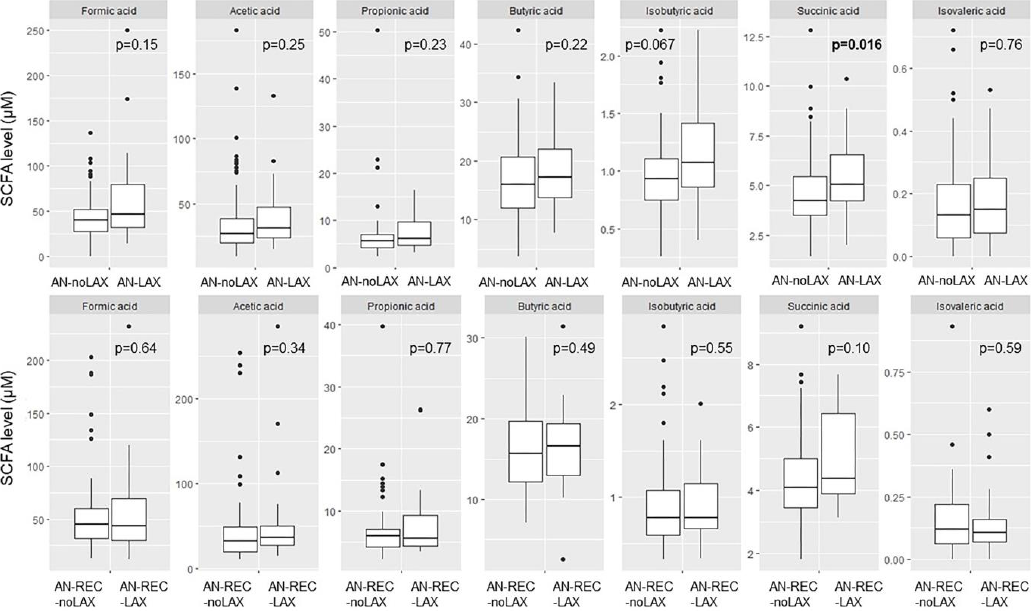
Figure 3. Box plots illustrate group differences in adjusted plasma concentration of SCFA in active and recovered AN with (AN-LAX, AN-REC-LAX) and without (AN-noLAX, AN-REC-noLAX) documented episodes of laxative use. The median is shown as a straight line and the box denotes the interquartile range. p < 0.017 is considered significant. Significantly reduced butyric acid was seen for AN-VOM compared with AN-no- VOM. No other significant differences were seen for neither AN nor AN-REC with re- gards to self-induced vomiting (Figure 4).